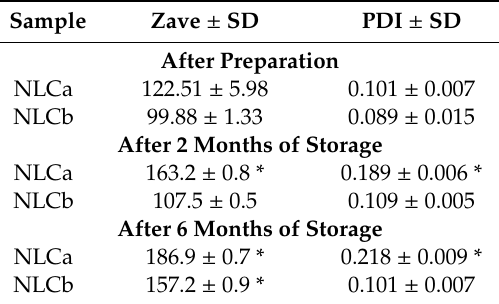
Table 2. Mean particle size (Zave, nm) and polydispersity index (PDI) ± standard deviation (SD) of unloaded NLCa and NLCb stored in Turbiscan ® at 25 ◦ C and analyzed after preparation and after two or six months. Each value is the average of six di ff erent replicates ± standard deviation (SD). * Significance for p < 0.05, comparison between NLC analyzed at di ff erent time intervals.